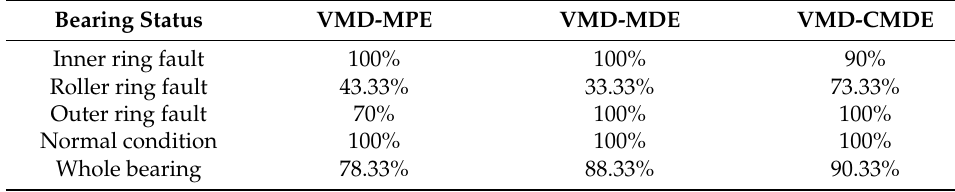
Table 4. DBN model accuracy.